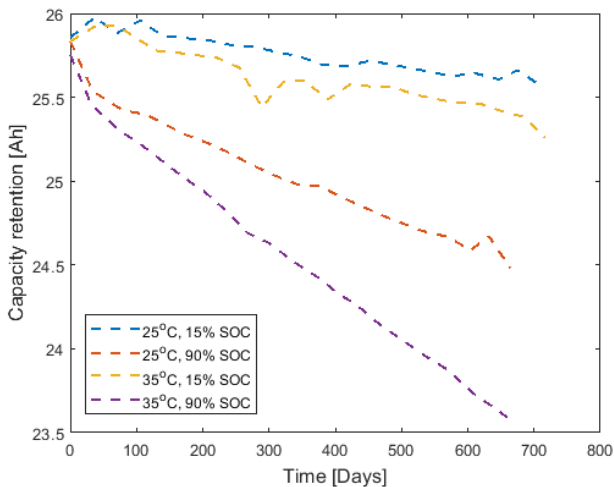
Figure 3. Calendar ageing in 25 ◦ C and 35 ◦ C at 15% and 90% State of Charge